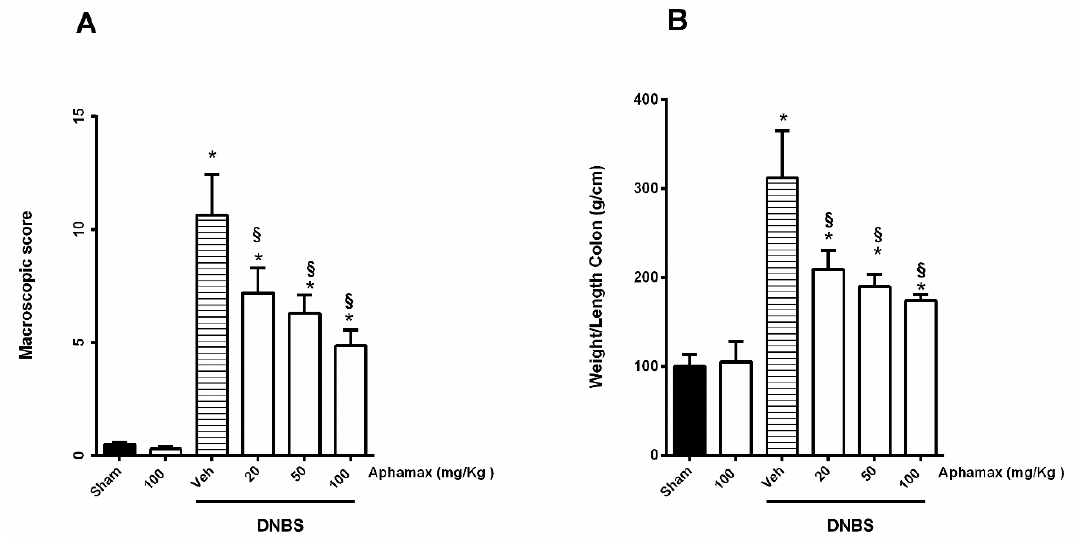
Figure 1. E ff ects of Aphamax ® on DNBS-induced macroscopic colonic damage. ( A ) Macroscopic damage score based on Appleyard and Wallace method and ( B ) Colon weight / Length ratio in sham rats or in Aphamax ® -treated rats with or without colitis induction. Data are means ± S.E.M. n = 5 animals / group. * p < 0.05 versus Sham animals; § p < 0.05 versus 2,4 dinitrobenzensulfonic acid (DNBS) animals.